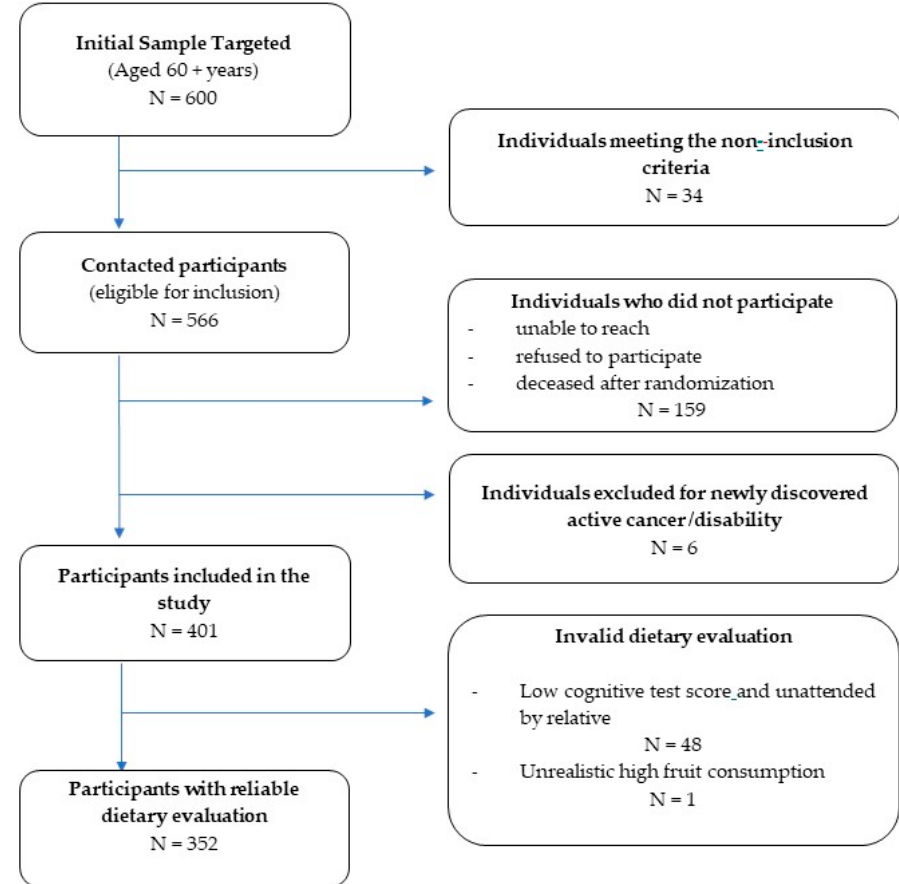
Figure 1. Study Flow chart.